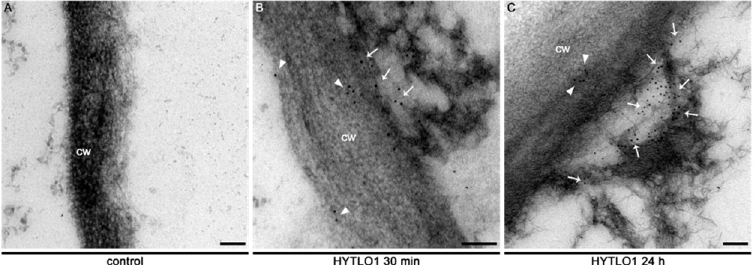
Figure 6. Immunocytochemical analysis of L. japonicus cells treated with HYTLO1. Cells were incubated: ( A ) in control conditions; ( B ) with HYTLO1 (0.6 µM) for 30 min; ( C ) with HYTLO1 (0.6 µM) for 24 h. Immunogold labelling was carried out by incubation with an affinity-purified anti- Immunogold-labelled particles are visible at the external surface (arrows) and across the plant cell wall (arrowheads). cw, cell wall. Bars, 100 nm.